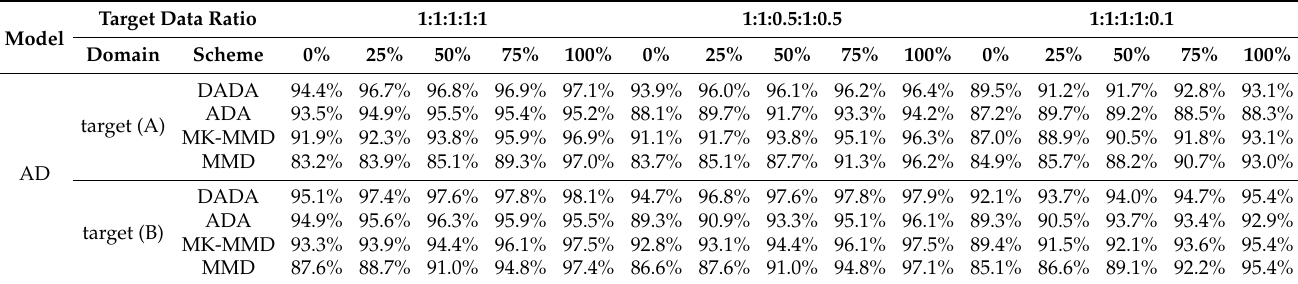
Table 6. Recognition accuracy (RA) of all cases for encountering for target (A) and target (B). Target Data Model